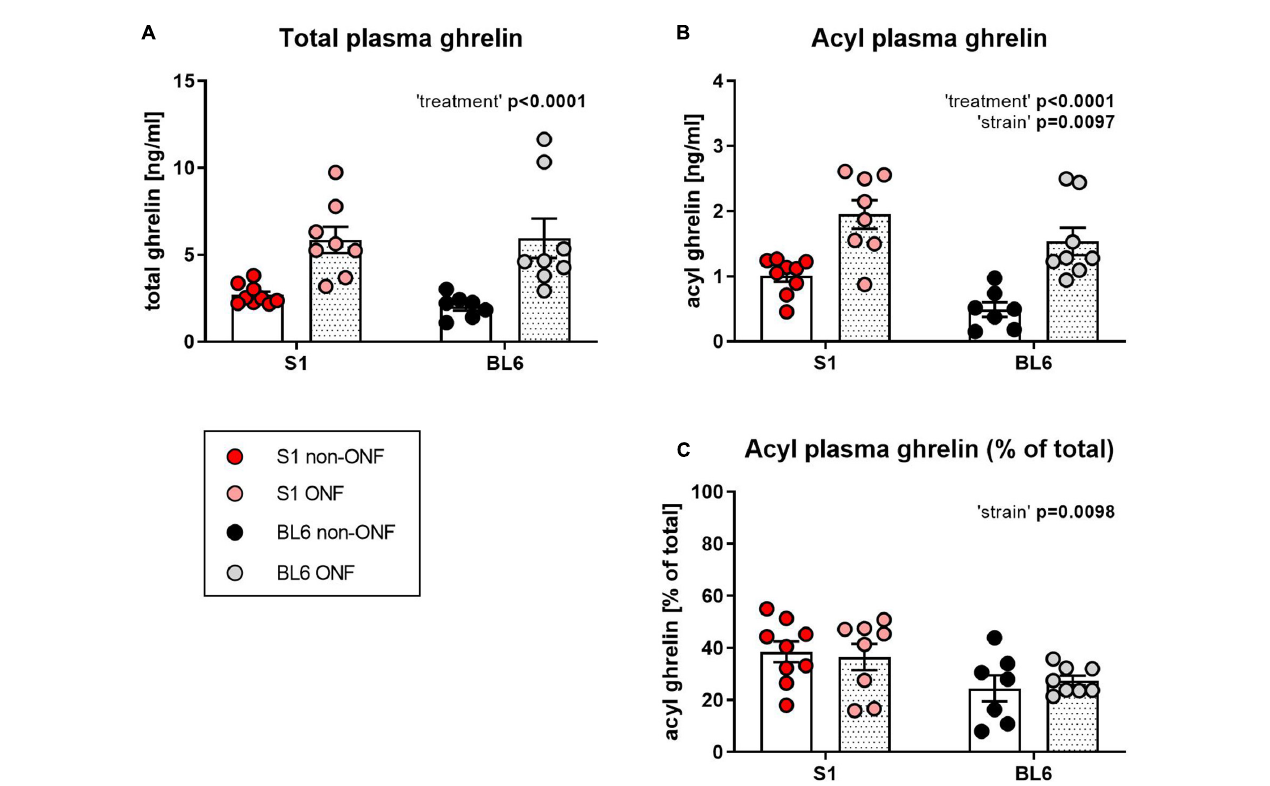
FIGURE2 Plasma ghrelin levels of overnight fasted and not fasted 129S1/SvImJ (S1) and C567BL/6J (BL6) mice. (A) Total ghrelin plasma levels. Regardless of strain, total ghrelin levels were increased in fasted mice [“treatment” p < 0.0001, F (1, 28) = 25.52]. (B) Acyl ghrelin plasma levels. Acyl ghrelin levels were increased in fasted mice of both strains, but higher in S1 than BL6 mice regardless of feeding status [“treatment” p < 0.0001, F (1, 28) = 34.72; “strain” p = 0.0097, F (1, 28) = 7.716]. (C) Percentage of acyl ghrelin of total plasma ghrelin. Acyl ghrelin percentage was not influenced by fasting, but higher in S1 than in BL6 mice [“strain” p = 0.0098, F (1, 28) = 7.672]. Figure info: S1 ONF (pink): n = 8; S1 non-ONF (red): n = 9; BL6 ONF (gray): n = 8; BL6 non-ONF (black): n = 7. All data points are individual values. All bars represent group means ± SEM. ONF, overnight fasted.